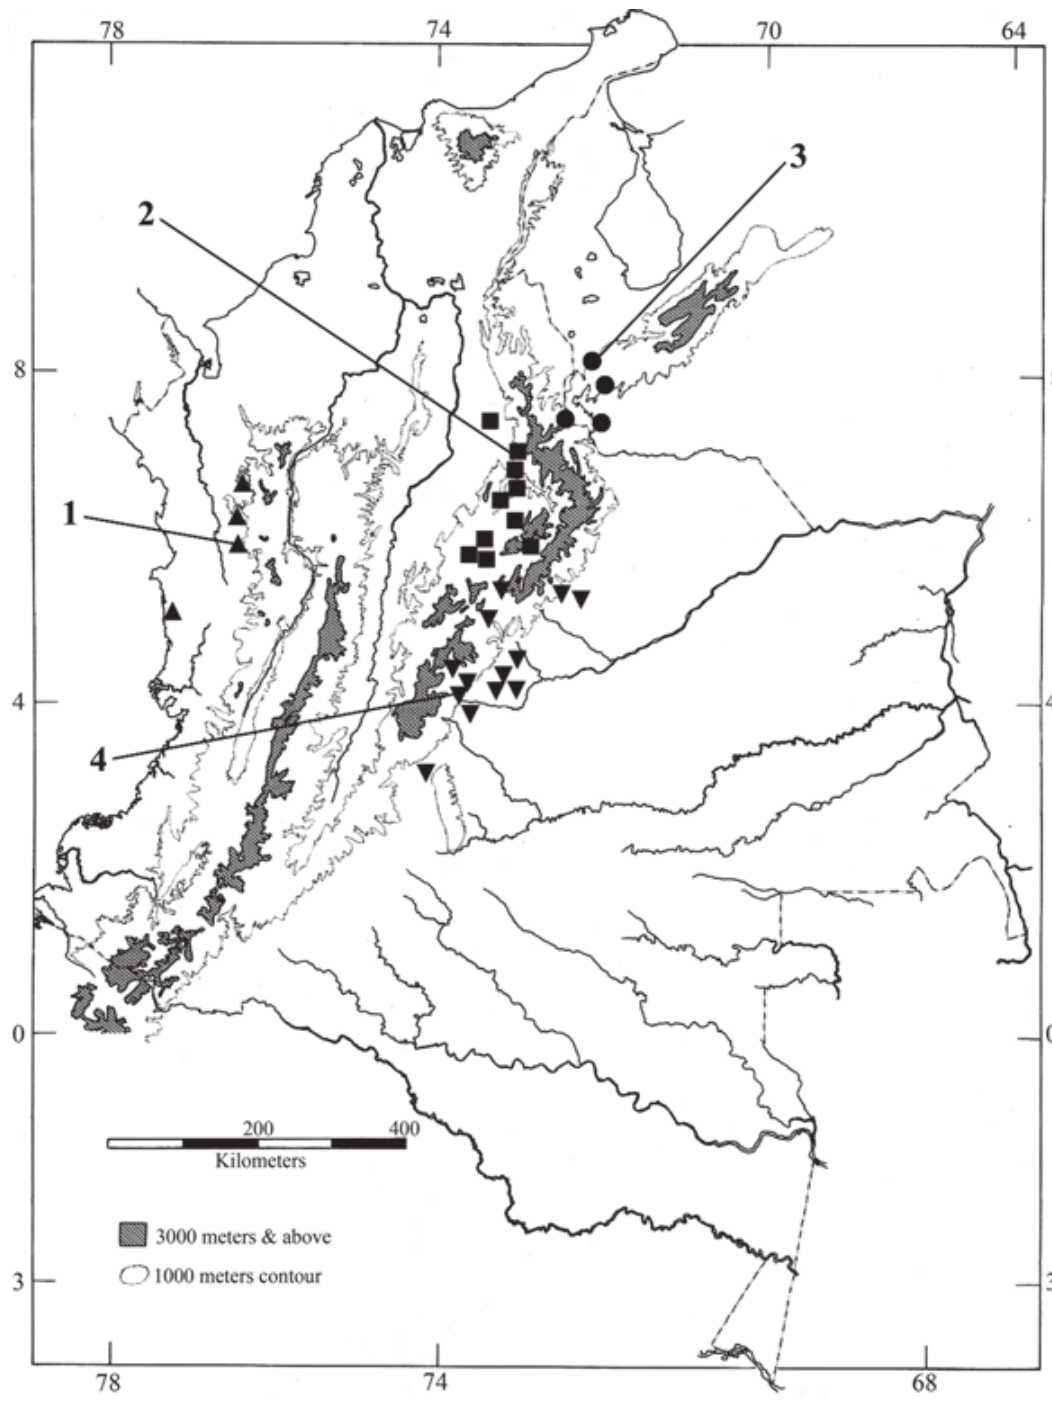
Fig. 2. Map of Colombia showing localities for the species of Dolichancistrus . Dotted contours represent 1000 masl isoclines and striped areas indicate regions above 3000 masl. Some symbols represent more than one locality and/or lot of specimens. Dolichancistrus atratoensis (triangles; type locality = 1); D. carnegiei (squares; type locality = 2); D. cobrensis (circles; type locality = 3); D. fuesslii (inverted triangles; type locality = 4). Base map provided by John D.